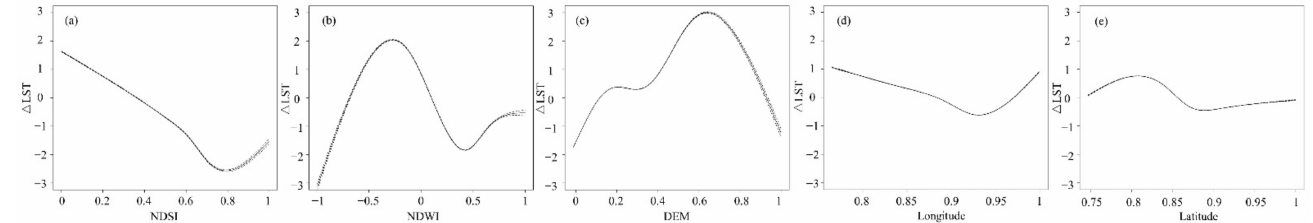
Figure 7. GAM analysis in snowing season: partial dependence plots of ∆ LST with NDSI ( a ), NDWI ( b ), DEM ( c ), longitude ( d ), and latitude ( e ).